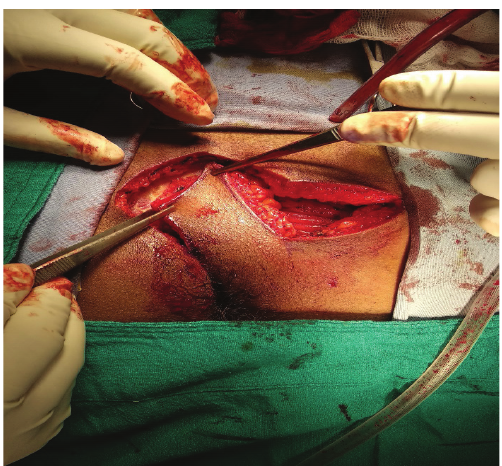
Figure 6: Tension-free flap of unscarred skin in